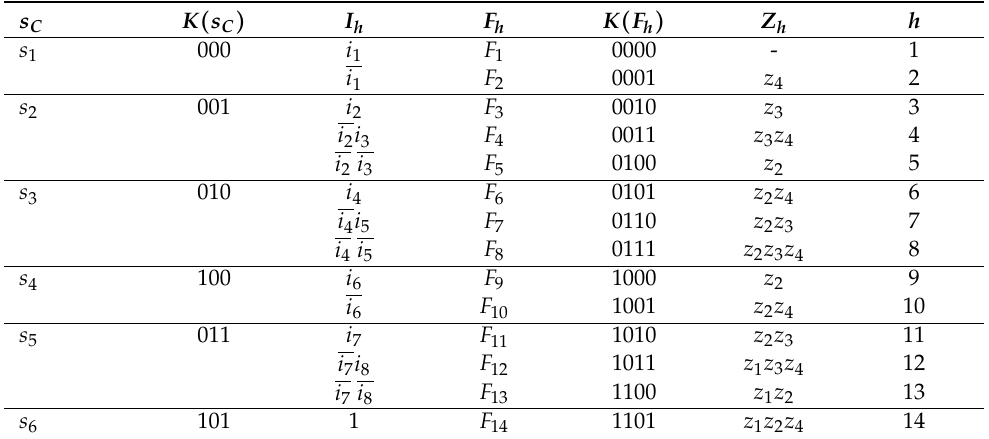
Table 7. DST of PH Mealy FSM A 2 .